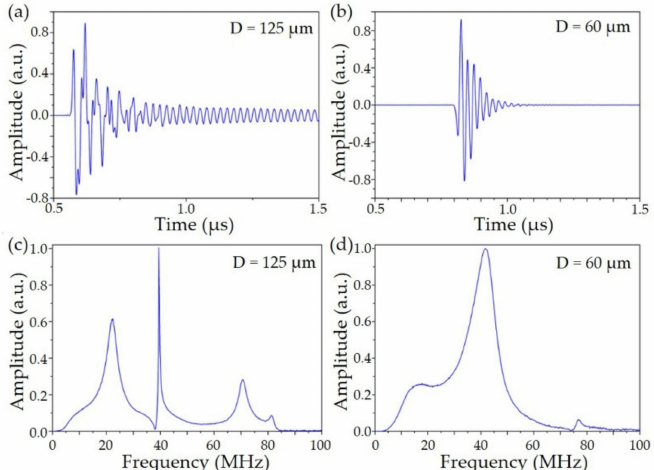
Figure 6. Transient response to a pulsed planar wave with di ff erent fiber diameter. Time domain responses of the 125 µ m ( a ) and 60 µ m ( b ) fiber sensor. Frequency responses of the 125 µ m ( c ) and 60 µ m ( d ) fiber